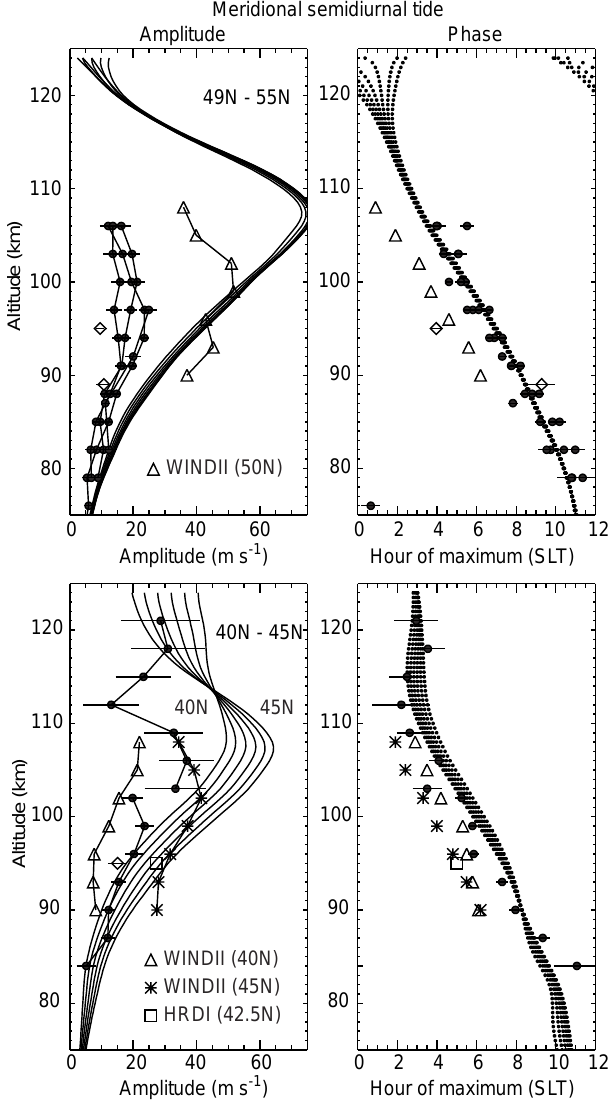
Fig. 7. The amplitude ( top left ) and phase ( top right ) of the meridional semidiurnal tide from 49–55 (cid:14) N are shown for Sylvan Lake, Saskatoon, Collm, Robsart ( all filled circles ), Obninsk, Juliusruh ( diamonds ), WINDII at 50 (cid:14) N ( triangles ) and the GSWM (amplitude: solid line , phase: dots ). The amplitude ( bottom left ) and phase ( bottom right ) of the meridional semidiurnal tide from 40–45 (cid:14) N are shown for Urbana (below 103 km), Millstone Hill (above 103 km), Durham ( diamond at 95 km), WINDII at 40 (cid:14) N ( triangles ), WINDII at 45 (cid:14) N ( asterisks ), HRDI at 42.5 (cid:14) N ( square at 96 km) and the GSWM (amplitude: solid line , phase: